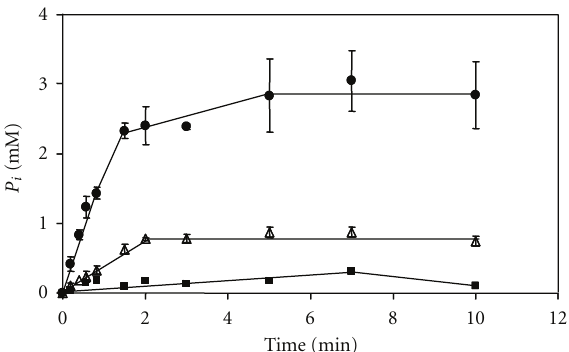
Figure 2: Activity measurement of the soluble type II pyrophos- phatase (Mthe 0236). Assays contained 40 mM Tris-HCl pH 8 with 5mM MgCl 2 and 1.25 μ g enzyme/mL. ( • ) activity measurement after 5 min preincubation with 1mM MnCl 2 , ( Δ ) activity without preincubation, and ( (cid:3) ) control without Mthe